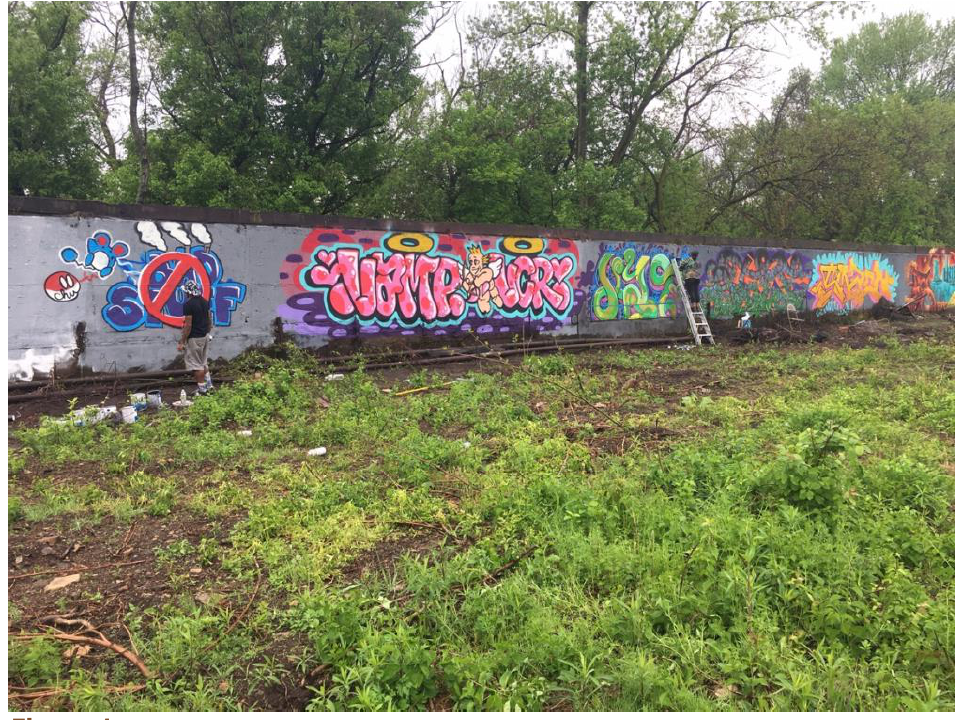
Caitlin Frances Bruce, Mural in Progress, 1, Aerosol paint on wall, 2017, Rankin, Pennsylvania. Copyright: